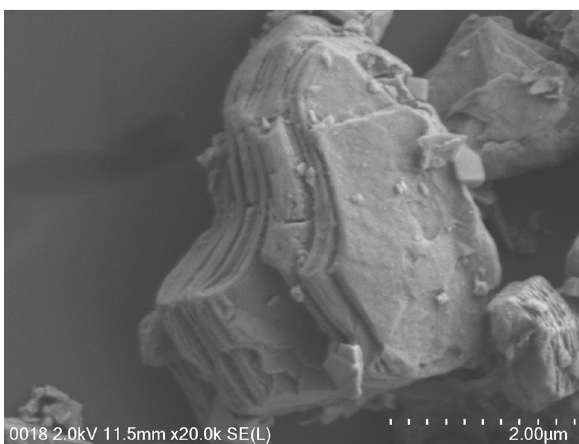
Figure 1. FESEM image of Nb 2 C MXene in the powder